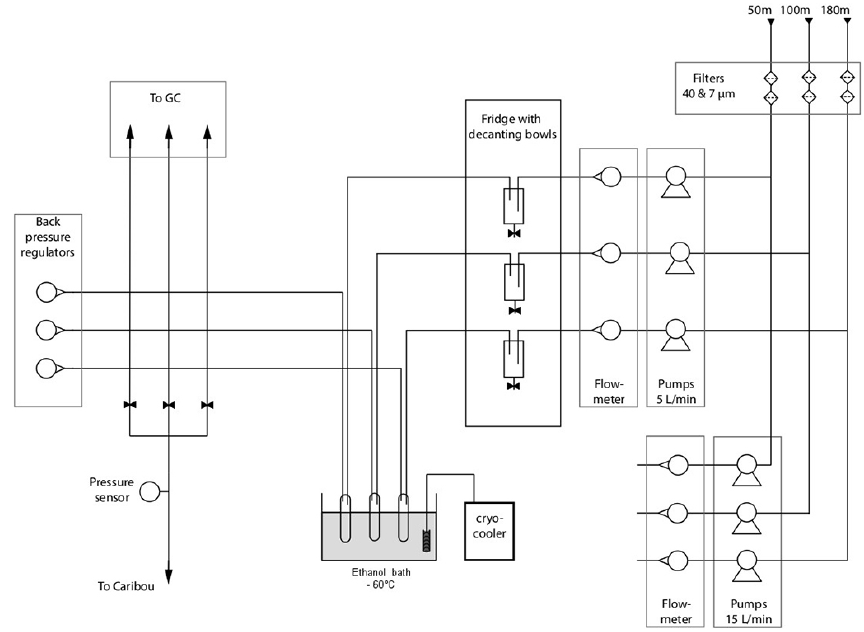
Figure 2. Schematic view of the air inlet and drying system controlled by the CARIBOU software. The dried air is used for GC and CARIBOU